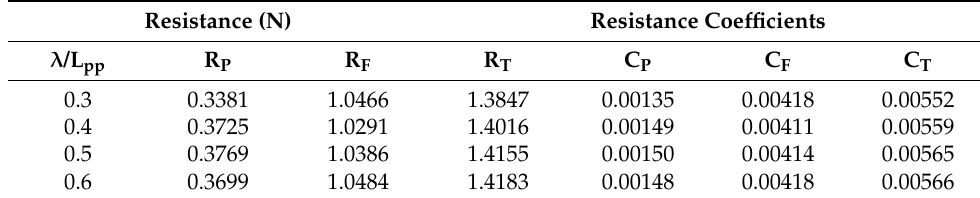
Table 7. Resistance acting on the bulbous bow model in waves.